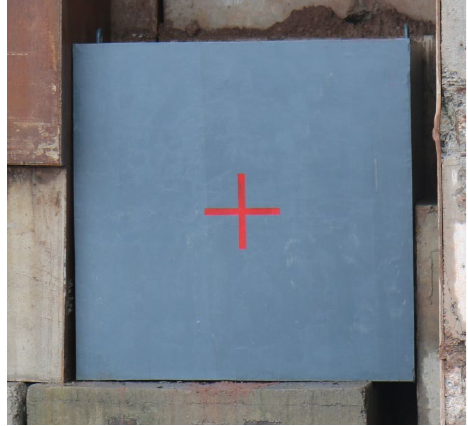
Figure 1. Cuboid UHPC target.